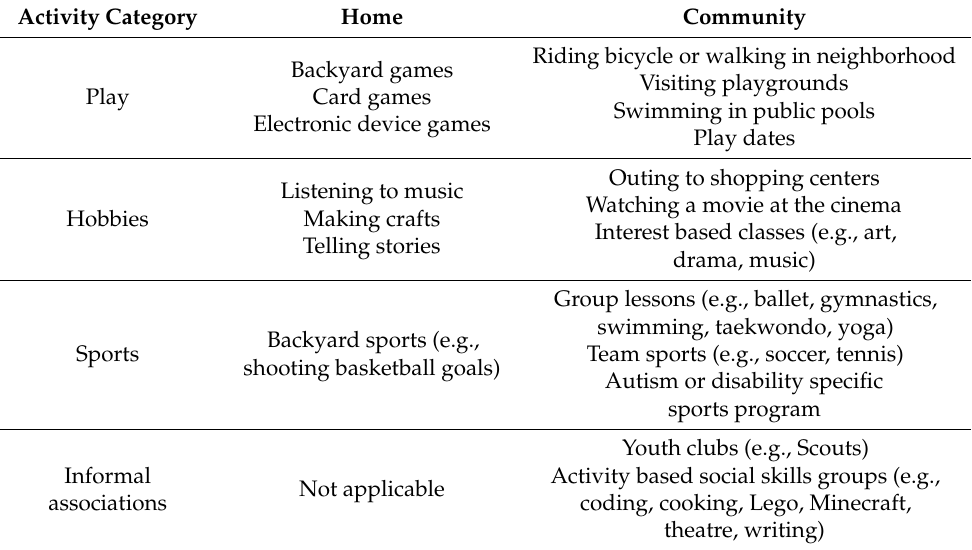
Table 3. Examples of activities at home and in the community that the young people need sup- port